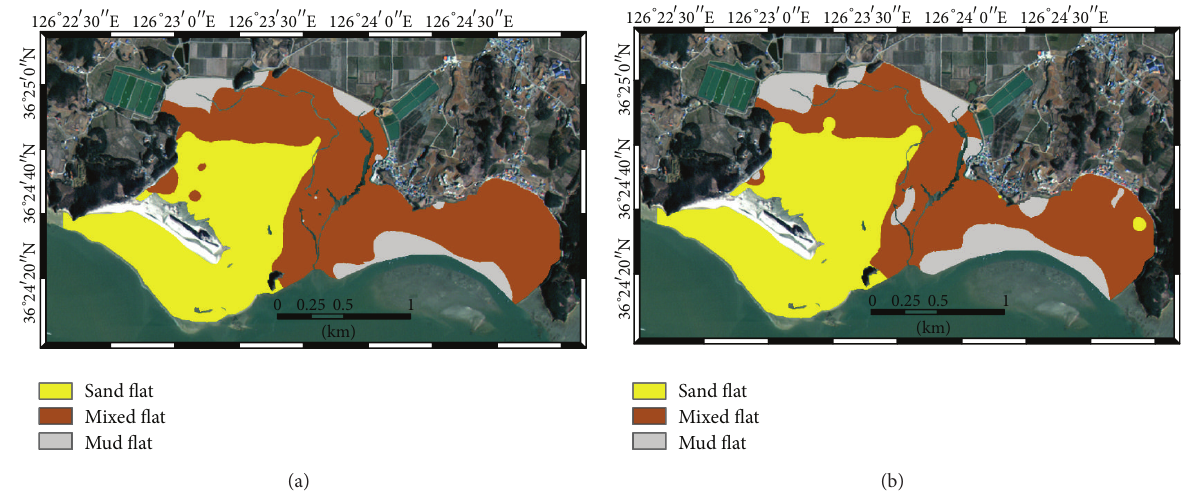
Figure 8: Surface sediment facies distribution generated by cokriging: (a) without and (b) with alr transformation.